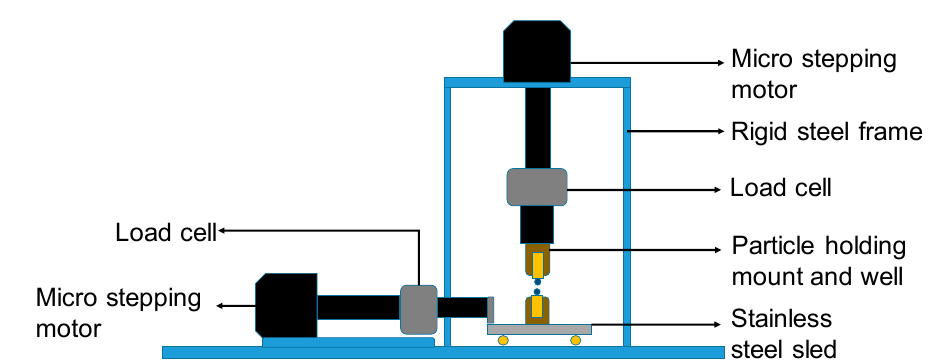
Figure 1. Schematic diagram of the inter-particle loading apparatus of the City University of Hong Kong.